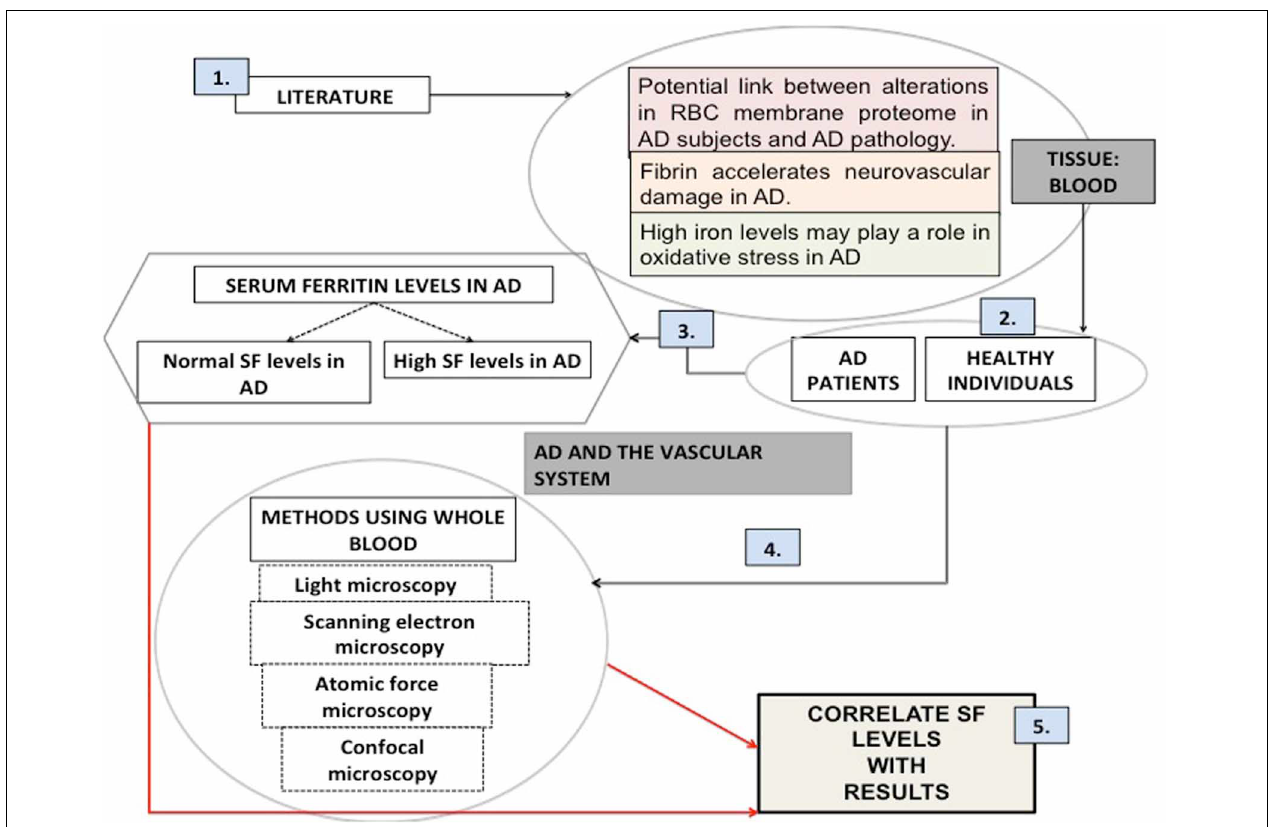
FIGURE 1 | An overview figure summarizing the contents of this manuscript. (1) Literature suggests that there is a rationale for looking at the vascular system and particularly blood; (2) our sample was chosen to be a random group of Alzheimer’s individuals (AD), as well as healthy individuals;